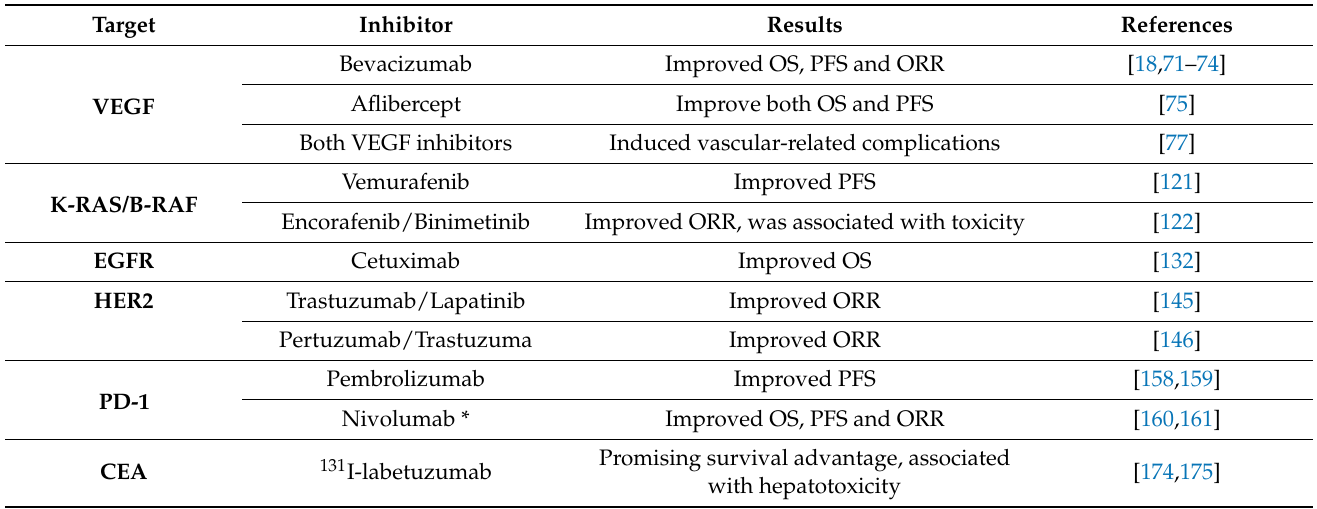
Table 1. Emerging targets for the management of metastatic CRC as recently reported by published clinical